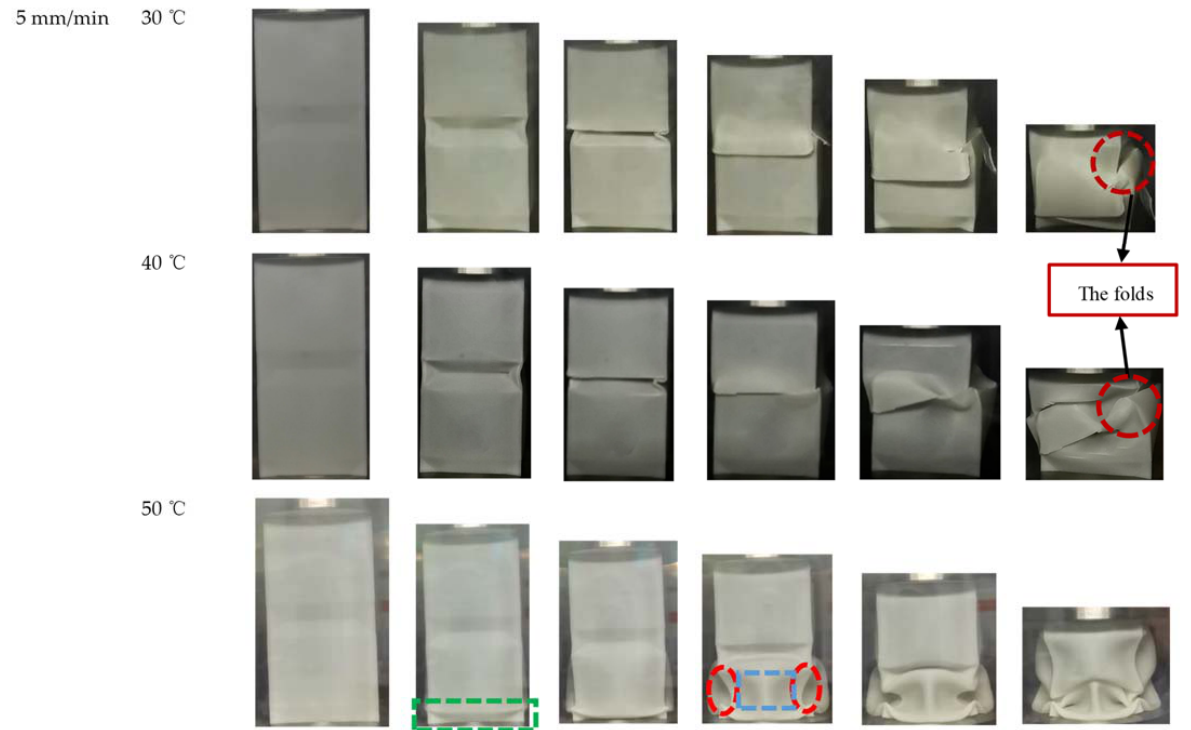
Figure 10. The compression rate at 5 mm/min: deformation modes of OET axial compression experiment at 30 °C, 40 °C, and 50 °C. Table 6. The compression rate at 5 mm/min: the energy absorption index of quasi ‐ static uniaxial compression experiment and numerical simulation of OET at 50 °C .